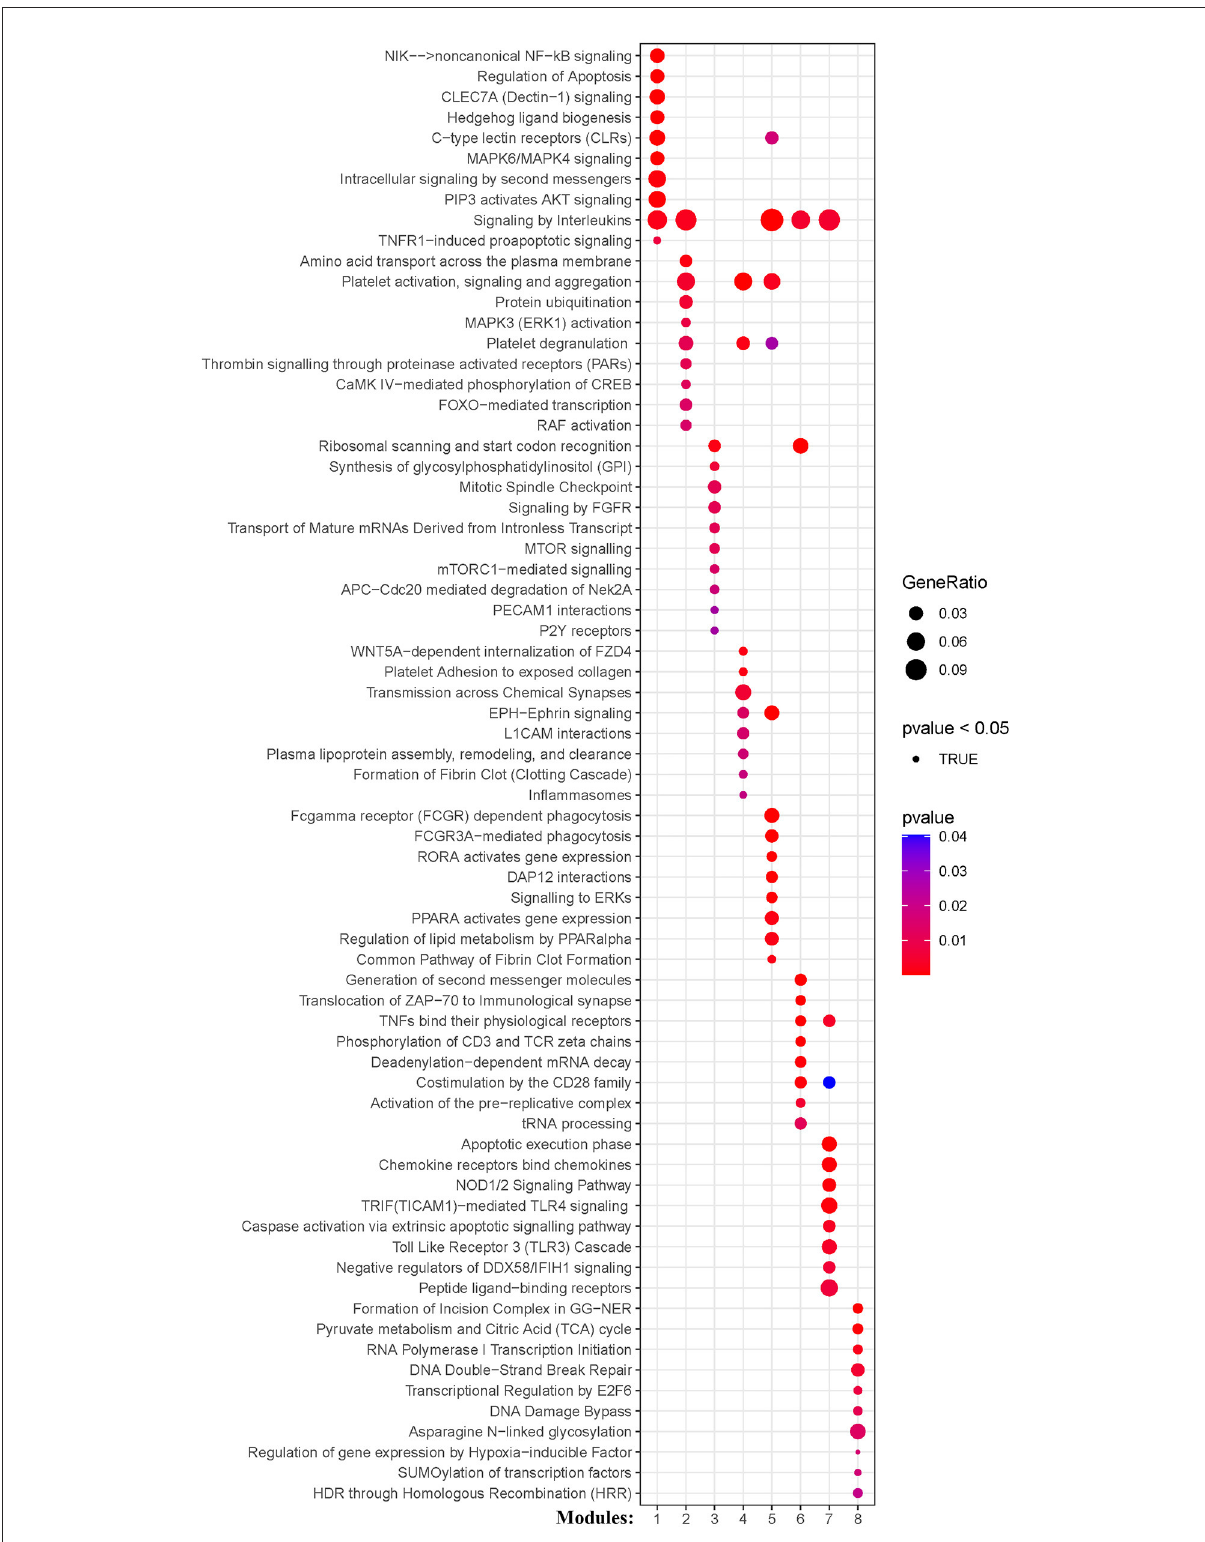
FIGURE9 Module-based pathway analysis. Visualization of pathways identified by the